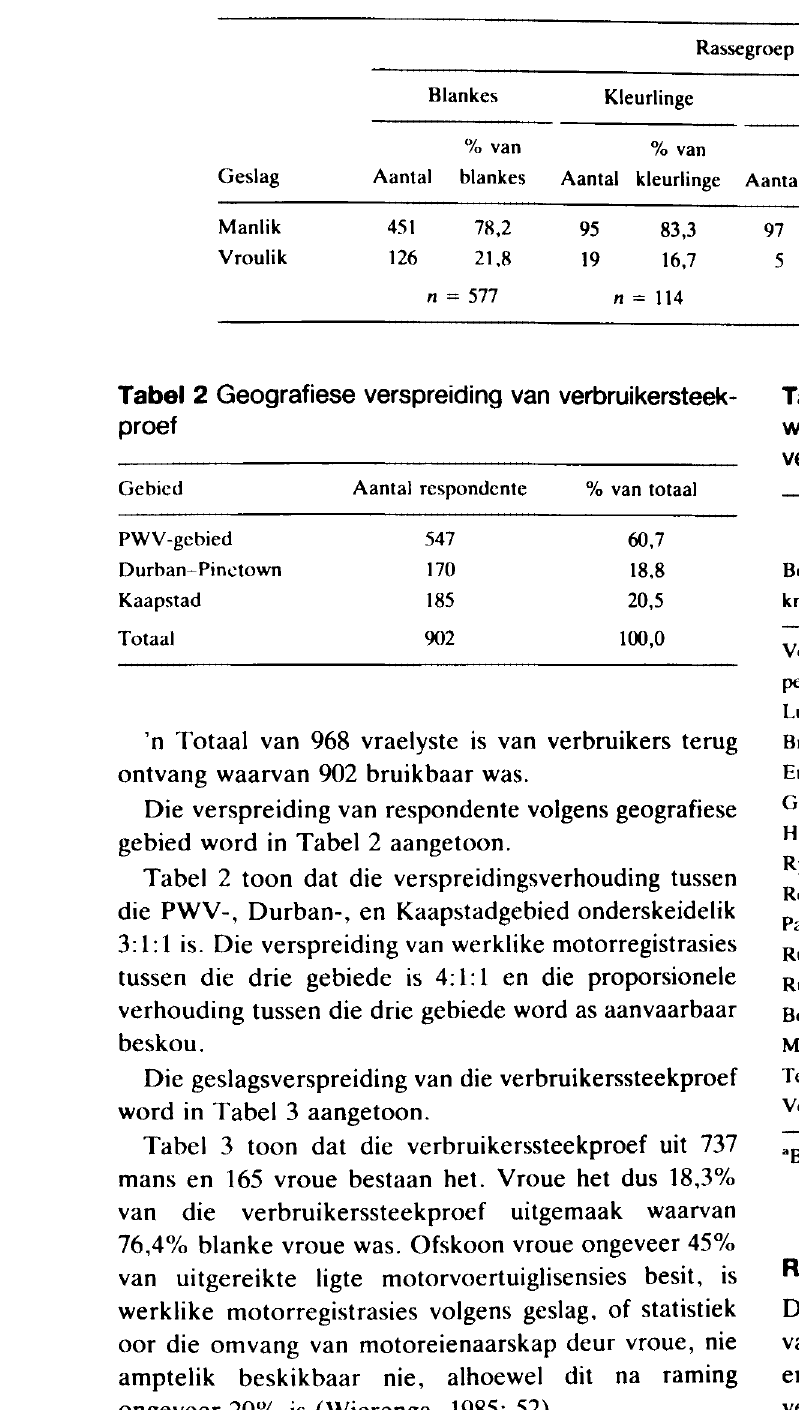
Tabel 2 Geografiese verspreiding van verbruikersteek proef Gebied Aantal respondente % van totaal PWV-gebied